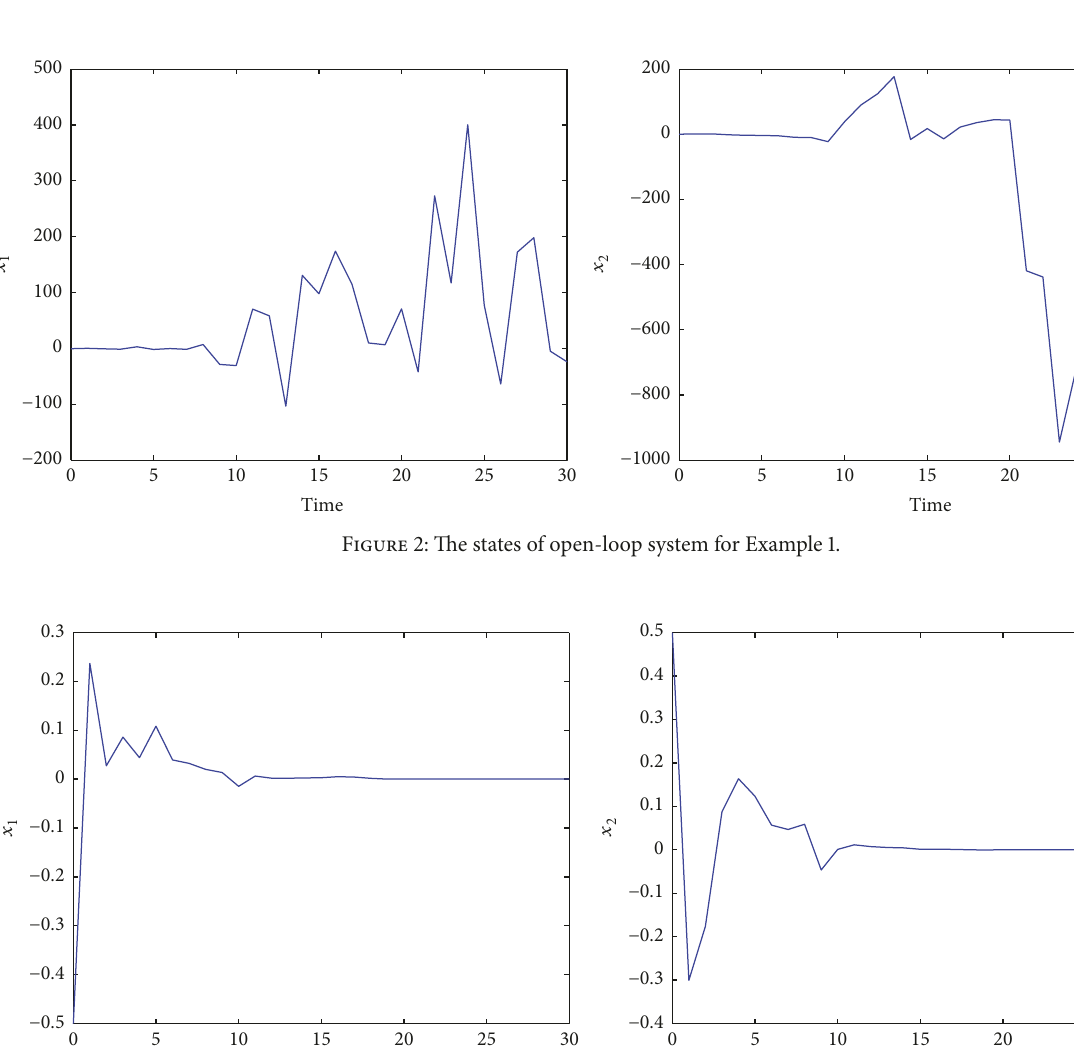
Figure 1: The system modes for Example 1.